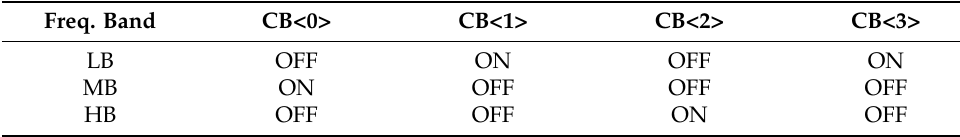
Table 2. Programmable digital control bits of capacitor